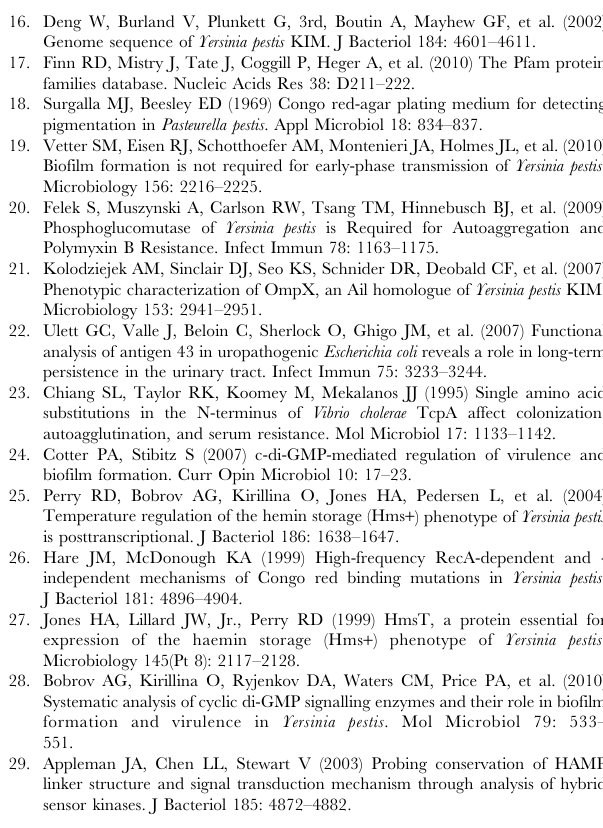
Figure S1 Y. pestis y3730 encodes a c-di-GMP synthesizing diguanylate cyclase (DGC) enzyme whose activity is dependent on the GGDEF domain. A. HPLC profile of a solution of 0.4 nmol synthetic c-di-GMP. B–H. HPLC quantification of intracellular levels of c-di-GMP in the Y. pestis hmsT y3730 hmsP triple mutant transformed with the empty plasmid vector (B, C) or with the plasmid vector containing hmsT (D, E), y3730 (F, G) or the mutated GGAAF allele of y3730 (H). Samples C, E, and G were supplemented with 1 nmol synthetic c-di-GMP. Arrows indicate the c-di-GMP peaks. (TIF) Figure S2 Loss of diguanylate cyclase (DGC) activity does not significantly reduce Y. pestis virulence in a mouse model of bubonic plague. Incidence of terminal disease in mice after subcutaneous injection of 100 CFU of Y. pestis KIM6 + (pCD1-kan) (white boxes) or KIM6 + D hmsT D y3730 (pCD1-kan) (black circles) is shown. All ten mice developed terminal plague after injection of the wild type Y. pestis KIM6 + , and 9 of 10 mice developed terminal plague after injection of the D hmsT D y3730 double mutant. Table S1 Sequences of primers and probes used in this